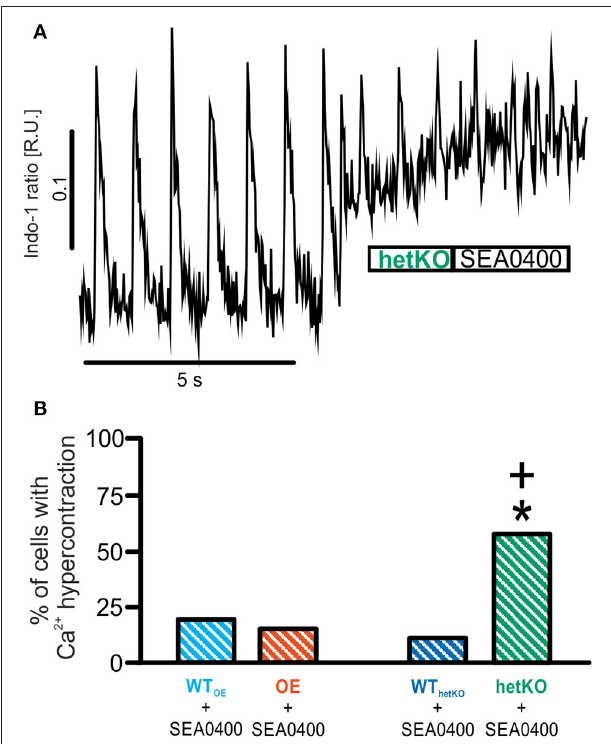
FIGURE 4 | Quantification of Ca 2 + hypercontractions as a measure for proarrhythmia. In a fraction of cardiomyocytes application of 1 µ M SEA0400 caused a sudden increase of the diastolic Ca 2 + level with highly frequent contractions and subsequent cell death (“Ca 2 + hypercontraction”) (B) as illustrated by the representative tracing in (A) . The proportion of cells with Ca 2 + hypercontractions was significantly increased only in the hetKO group. * p < 0.05 vs. basal; + p < 0.05 vs. WT; Fisher’s exact test with R.